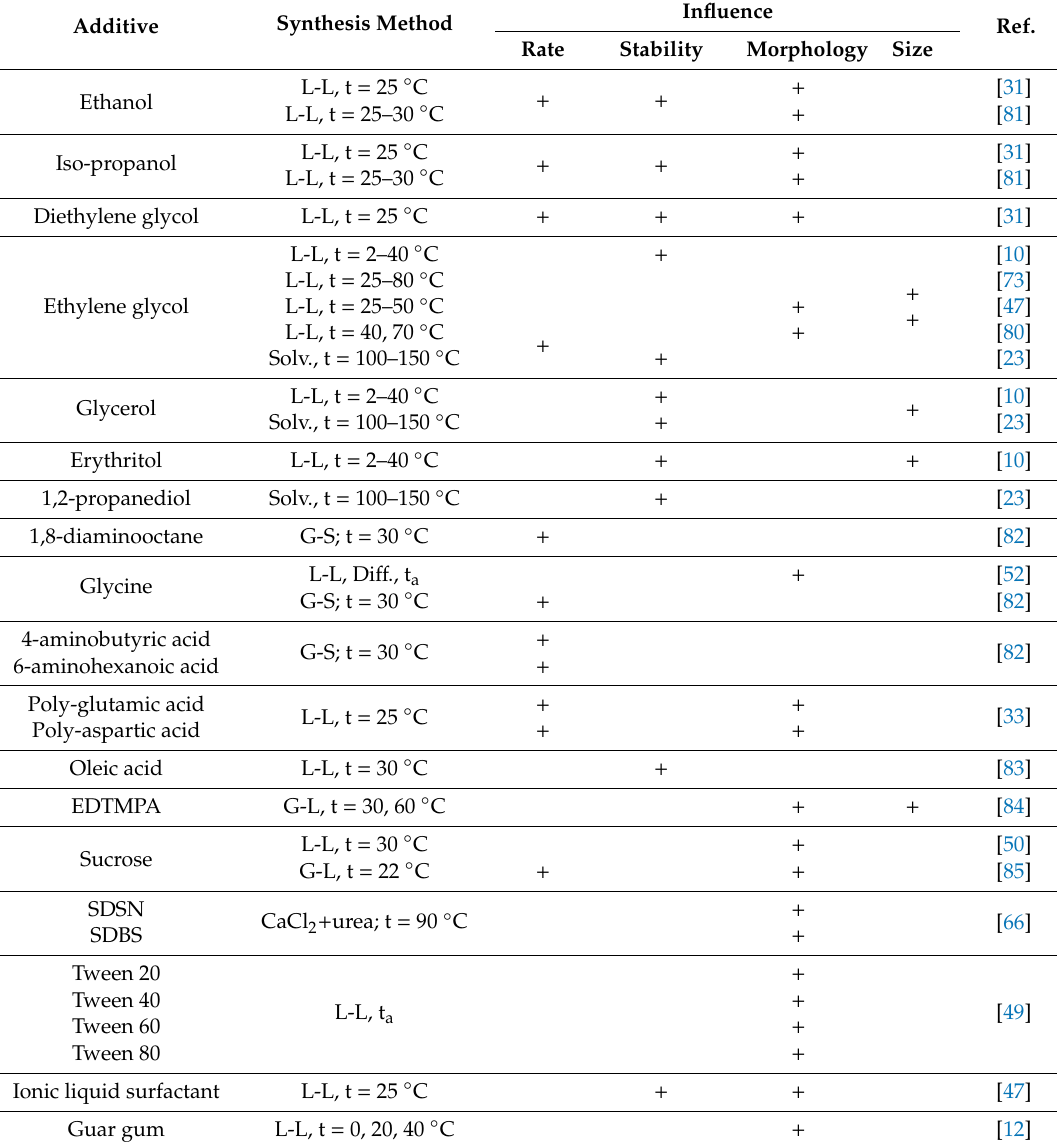
Table 3. The influence of selective additives on vaterite